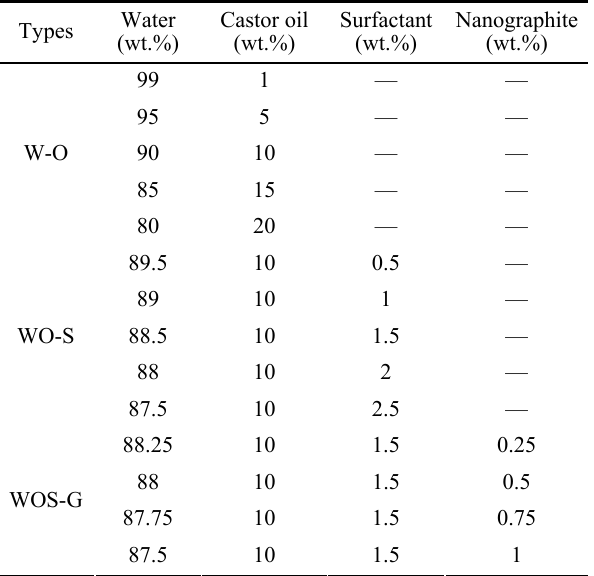
Table 2 Configuration of three types of cutting fluids.